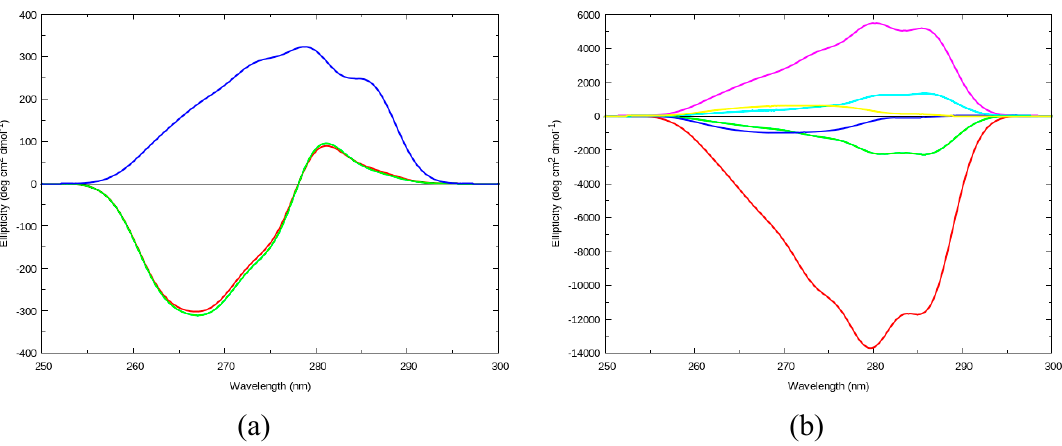
Figure 1. ( a ) Computed near-UV circular dichroism (CD) spectra for cPY_60 (red line), cPY_180 (green line), and cPY_300 (blue line); ( b ) Computed near-UV CD spectra for cYY_60_60 (red line), cYY_180_60 (green line), cYY_180_180 (blue line), cYY_300_60 (magenta line), cYY_300_180 (cyan line), and cYY_300_300 (yellow line). Spectra computed using BB and VSC parameters. CD spectra from rotational strength line spectra convoluted with a Gaussian of full-width half-maximum (FWHM) of 4.0 nm. BB: two amide backbone transitions, n π * and ππ *, VSC: vibrational fine-structure in the L b state of Tyr along with its vertical transitions L a , B a and B.